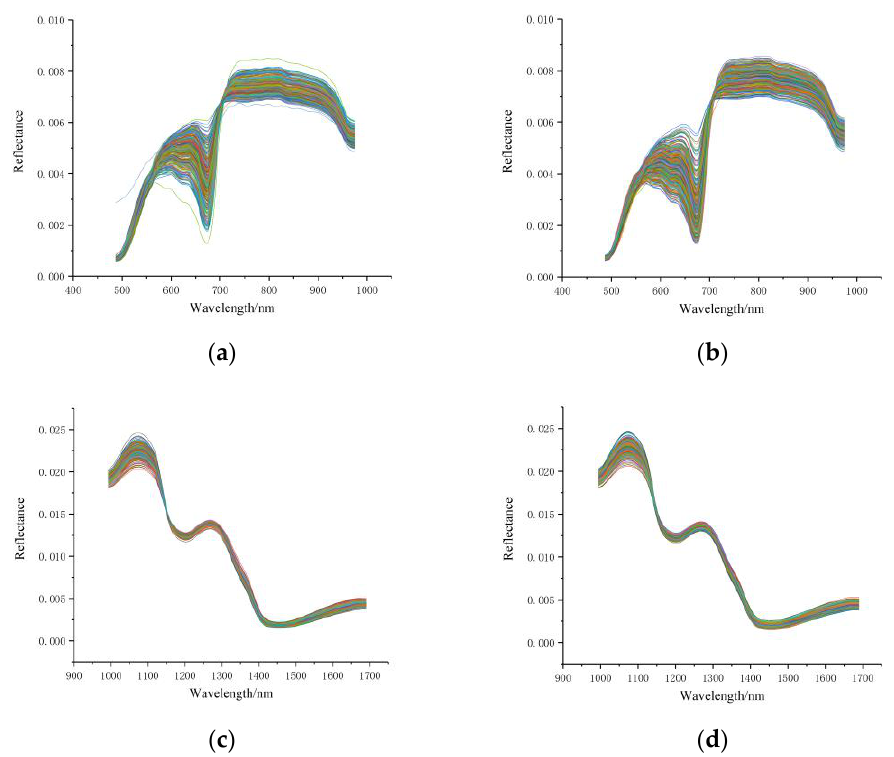
Figure 2. VIS/NIR spectra and NIR spectra of the fruit calyx and blossom ends. ( a ) VIS/NIR spectra of the fruit calyx end (FX10-SP-A); ( b ) VIS/NIR spectra of the fruit blossom end (FX10-SP-B); ( c ) NIR spectra of the fruit calyx end (FX17-SP-A); ( d ) NIR spectra of the fruit blossom end (FX17-SP-B).